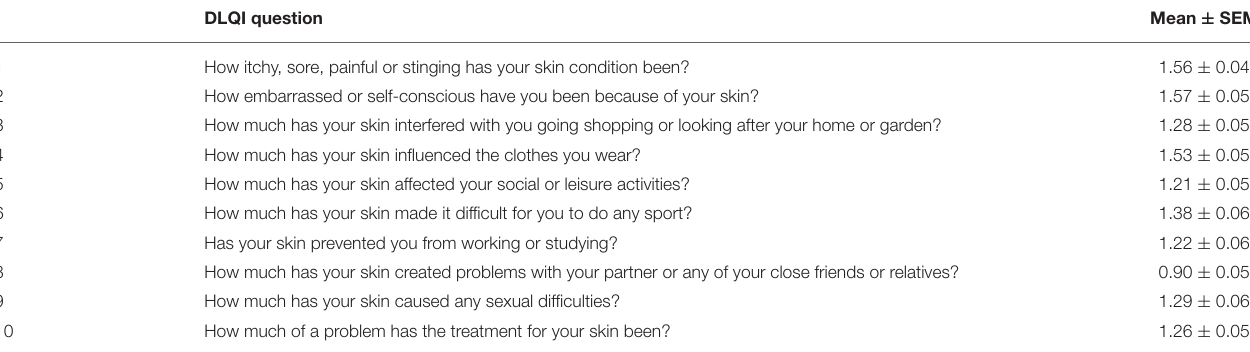
TABLE 2 | Mean scores for each DLQI question.